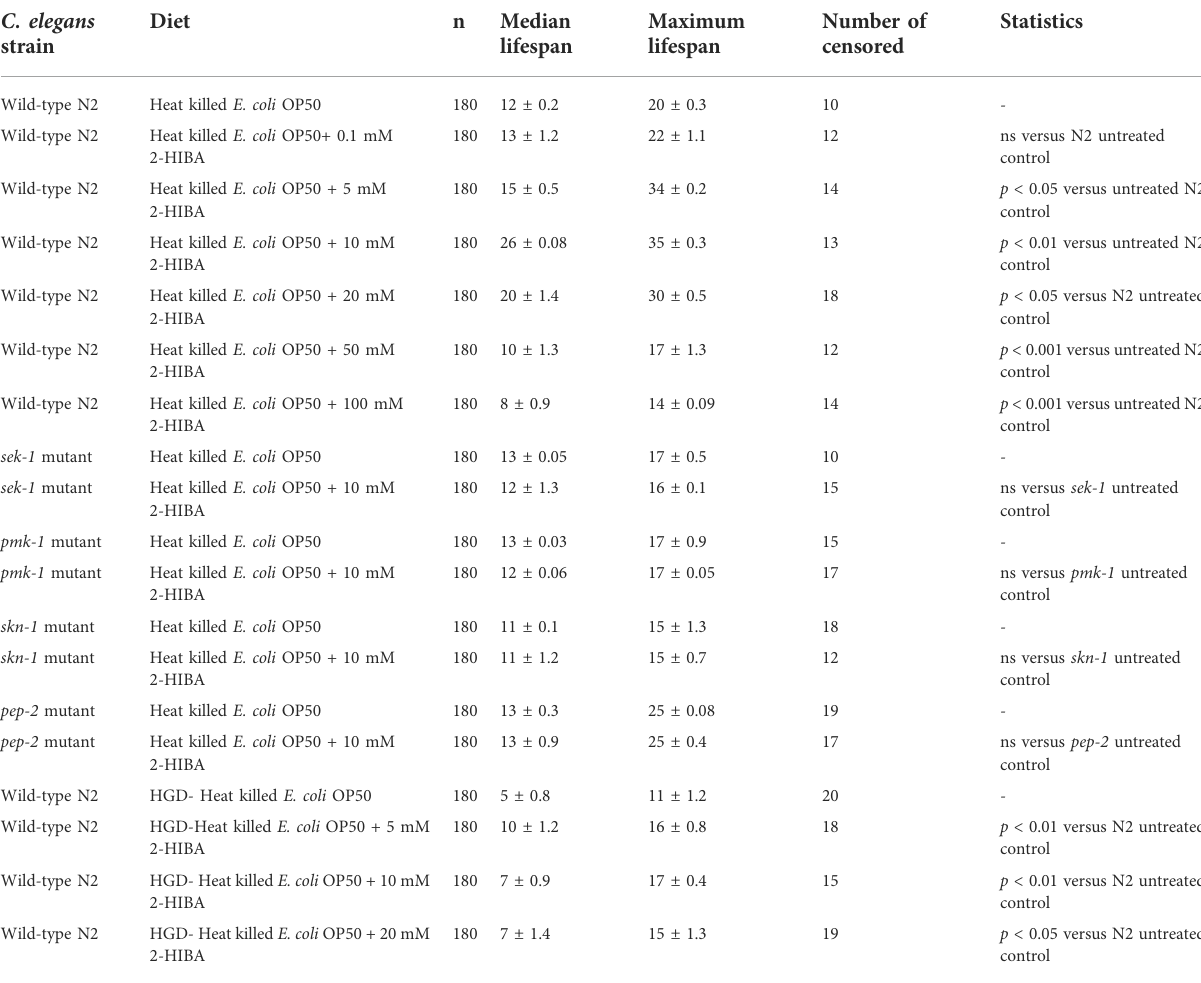
TABLE 1Lifespan analysis of wild-type N2, sek-1, pmk-1, skn-1 mutant worms supplemented with 2-HIBA in standard or HGD condition. The lifespan of untreated animals was reported as control. Three experiments were performed in triplicate for each